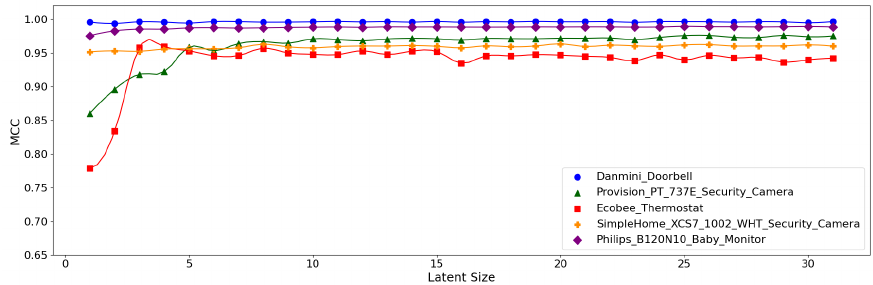
Figure 13. MCC per device for the N-BaIoT dataset when the (5,64) model is employed.